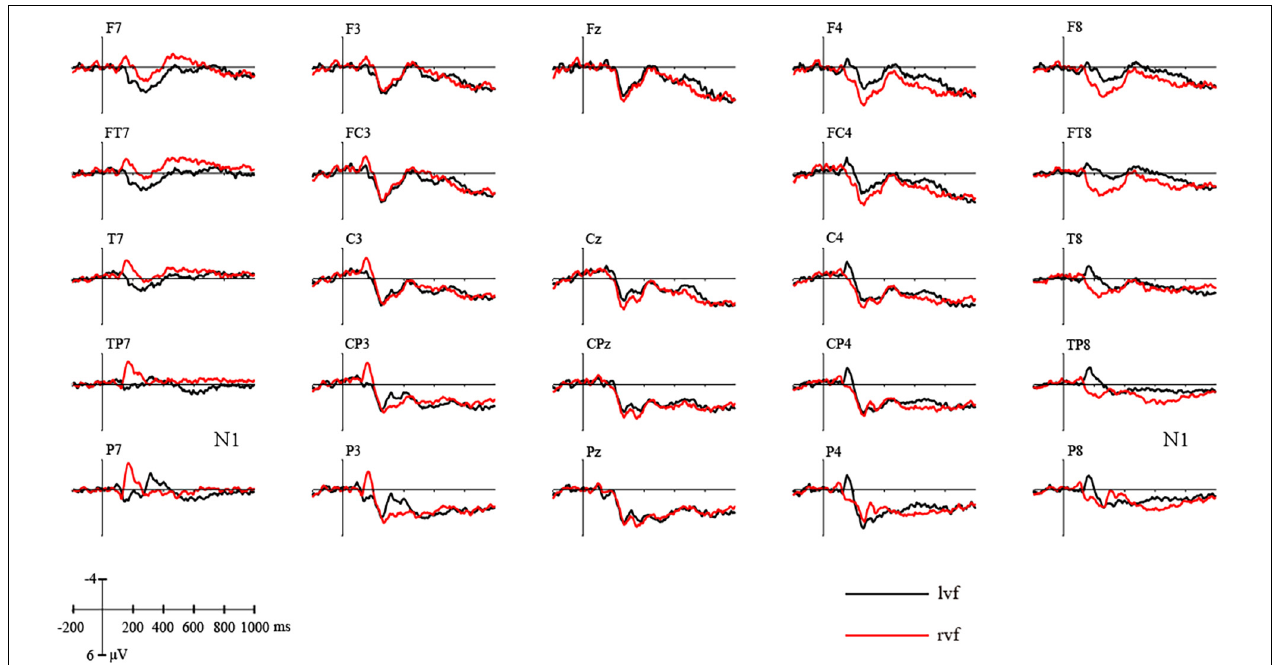
FIGURE 3 | Difference curves of the grand average ERPs elicited by stimuli presented on left visual field and right visual